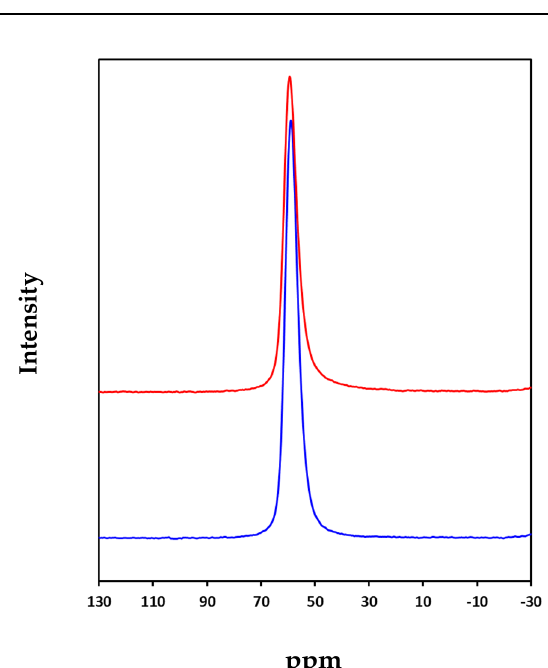
Figure 5. 27 Al MAS NMR spectra of Y and Y ‐ mod zeolites.